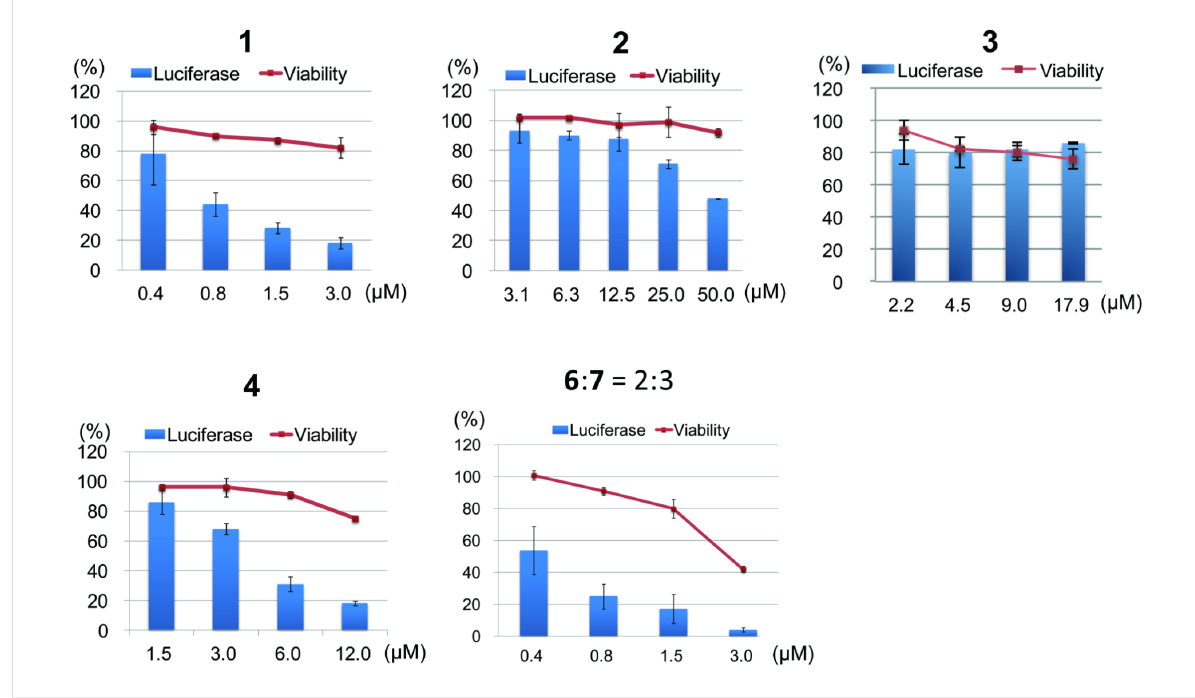
Figure 3: GLI1 transcriptional activity and cytotoxicity. Reporter activity (solid columns) and cell viability (solid curves) of compouds 1 – 4 and mixture of 6 and 7 (2:3). The assays were performed at 0.05% DMSO ( n = 3). Error bars represent SD.